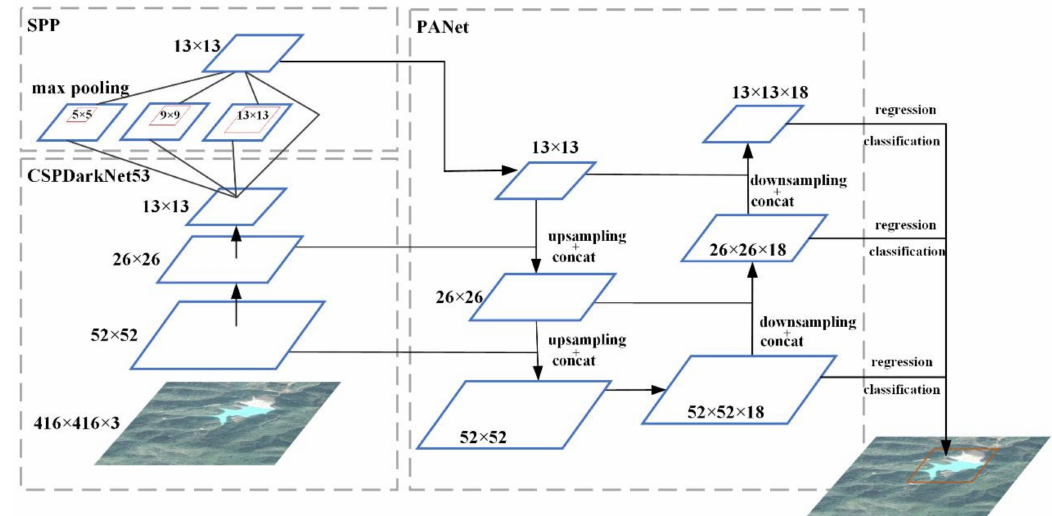
Figure 2. The main structure diagram of YOLOv4